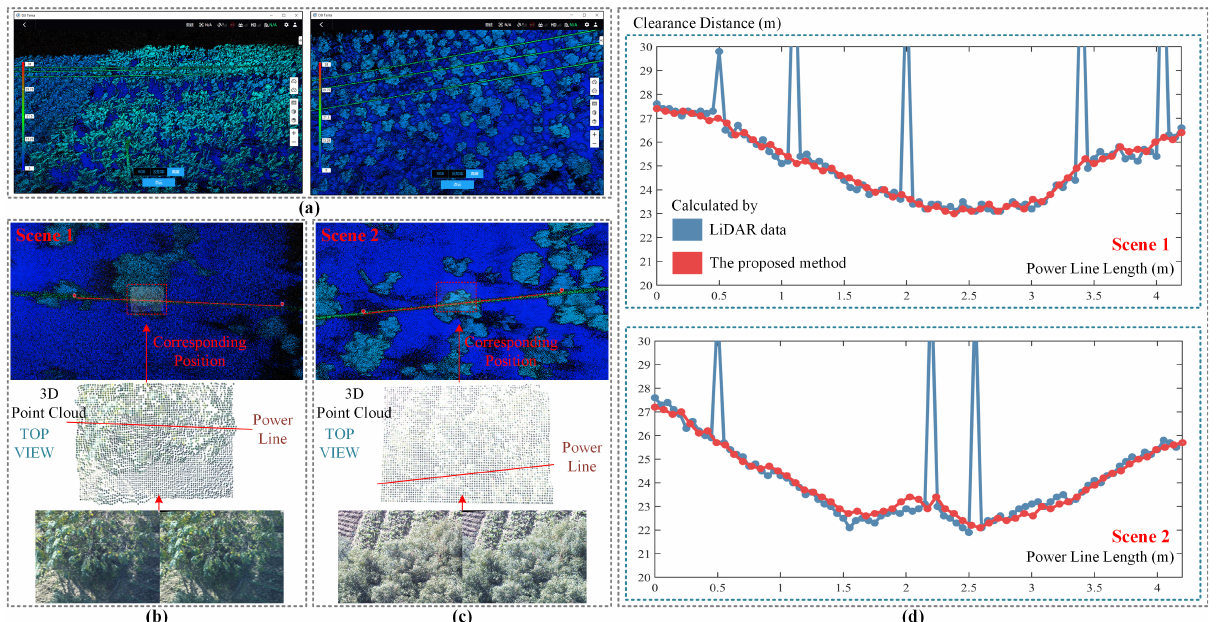
Figure 18. Experiments of ground clearance measurement. ( a ) Local 3D point clouds of transmission line acquired by Livox Avia LiDAR and its professional software. ( b , c ) Two different scenes for evaluation. ( d ) The clearance distances of power line points calculated by the LiDAR data and the proposed